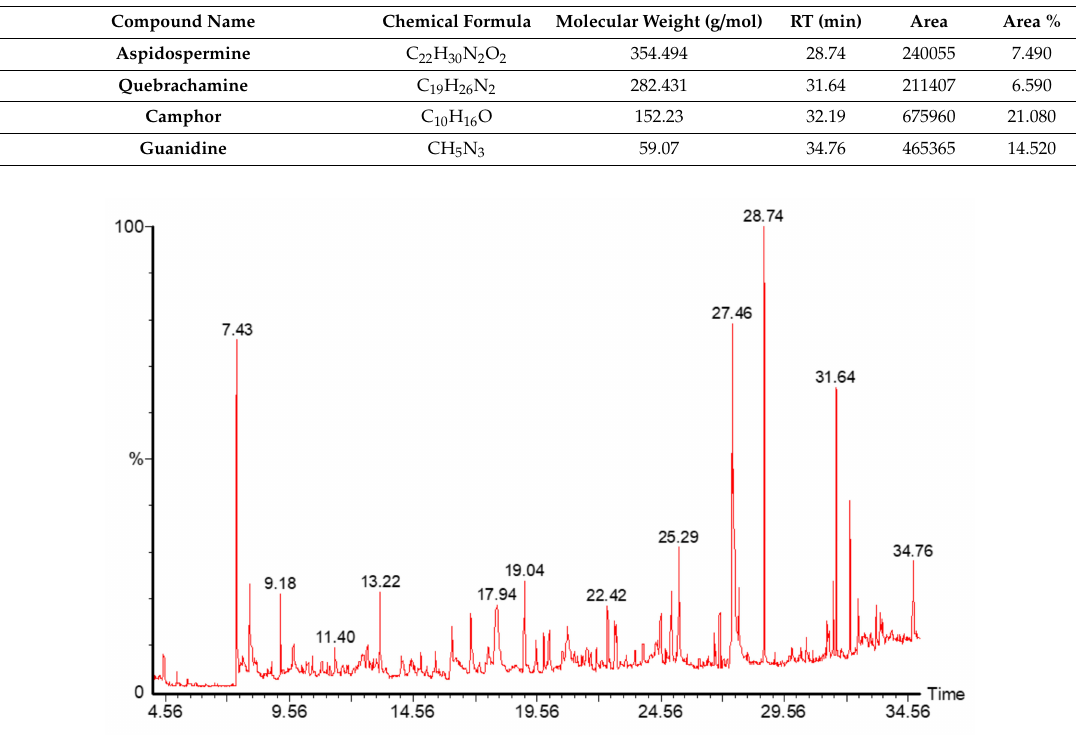
Figure 9. GC-MS analysis of phytochemical compounds in RSF EtOAc extract.